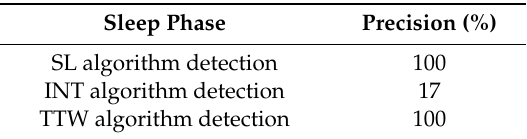
Table 4. The Precision Algorithm and detection accuracy of the AWAKE phases (SL, INT, and TTW) event detection.